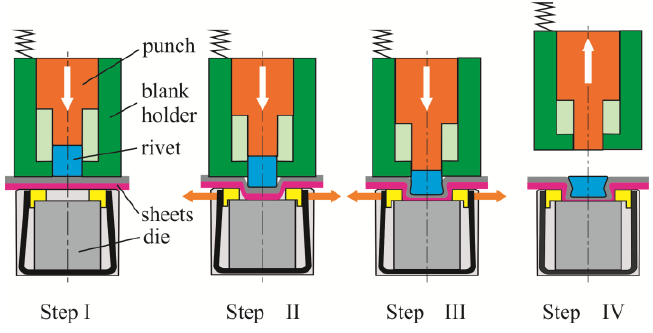
Figure 5. Steps of the ClinchRivet joining process.